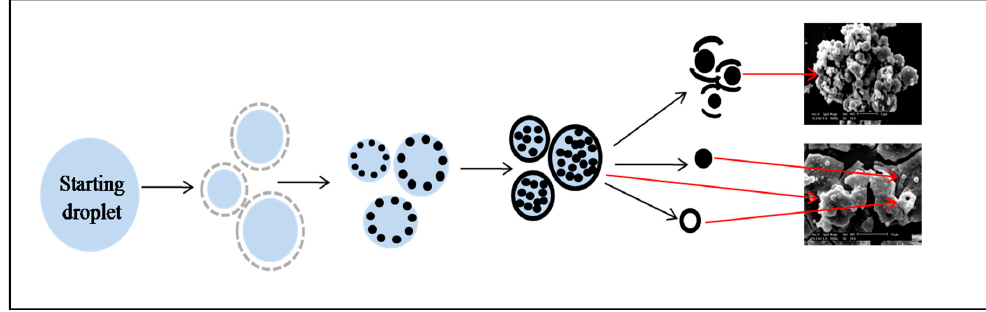
Figure 7. Possible route of particle formation in the SPPS process. Reproduced with permission from [39], Elsevier, 2017.